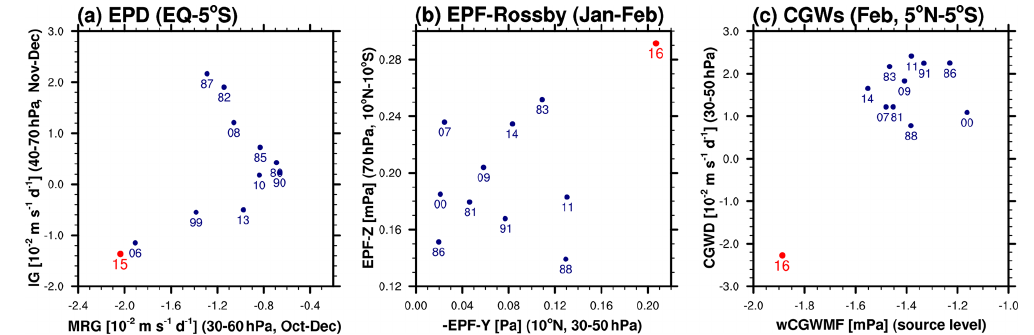
Figure 17. Scatter plots of the (a) EP flux divergence (EPD) for the MRG waves ( x axis) and that for the IG waves ( y axis) at 0–5 ◦ S, averaged for October–December at 40–60hPa and November–December at 30–70hPa, respectively. (b) Meridional EPF (multiplied by − 1) at 10 ◦ N and 30–50hPa ( x axis) and vertical EPF at 70hPa at 10 ◦ N–10 ◦ S ( y axis) for the Rossby waves averaged for January–February. (c) Westward CGW momentum flux at the source level ( x axis) and the zonal-mean zonal CGWD ( y axis) at 30–50hPa at 5 ◦ N–5 ◦ S averaged for February. Red dots denote the disruption year (2015/16), and dark blue dots denote the other years with WQBO